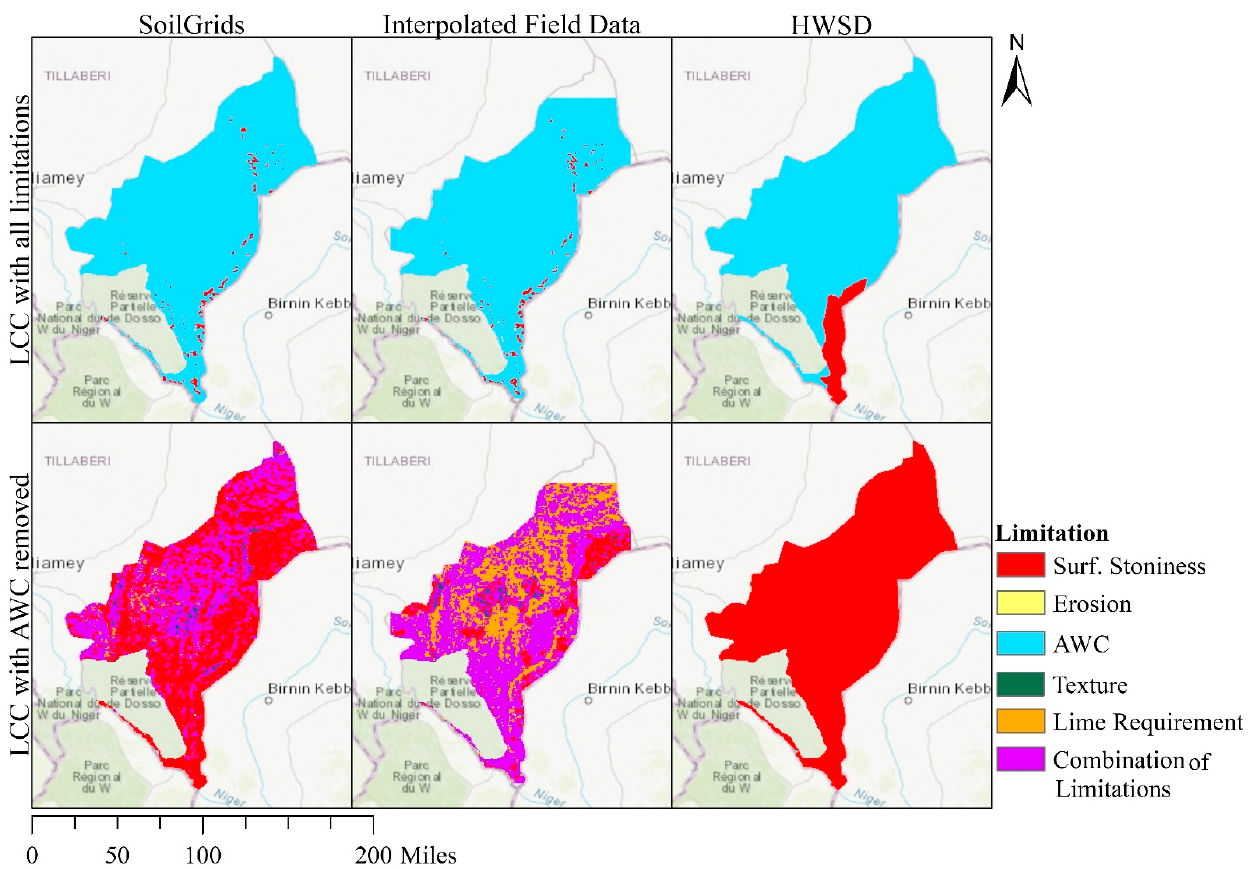
Figure 6. Limitation maps for SoilGrids, interpolated field data and Harmonized World Soil Database (HWSD). Note that the field data image uses surface stoniness inputs from SoilGrids resulting in the similar spatial patterning.